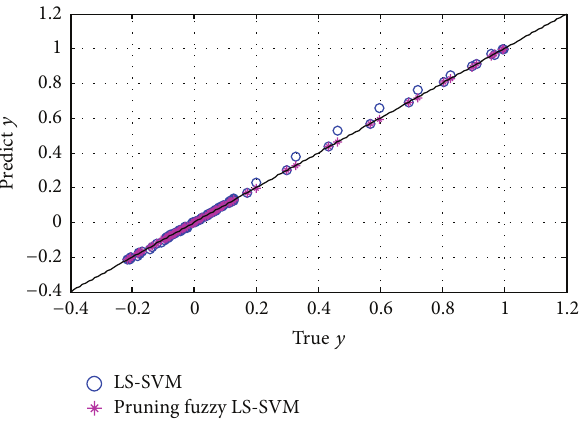
Figure 3: 45-degree comparison of the two soft sensors.